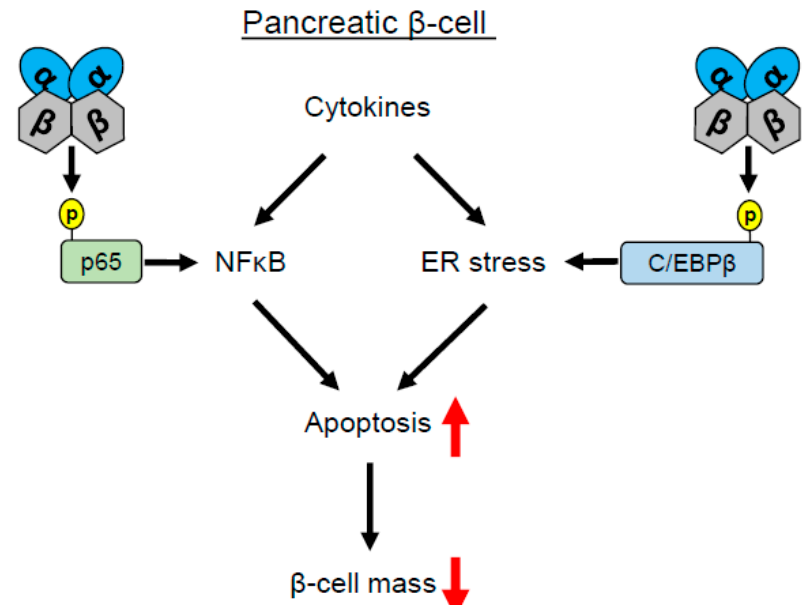
Figure 1. E ff ect of CK2 on inflammation-induced β -cell death. Cytokine-induced inflammation leads to phosphorylation of the NF κ B subunit p65 as well as ER stress-induced transcription factor C / EBP β . The phosphorylation of these proteins induces apoptotic signaling pathways, leading to a reduction of β -cell mass.